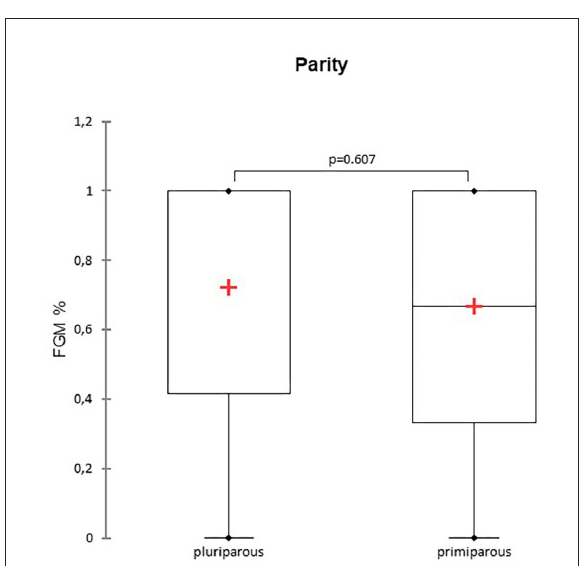
FIGURE3 The box plot reports the percentage of fetuses showing fetal gastrointestinal motility (FGM%) in pluriparous and primiparous bitches. The mean is indicated as a red cross ( + ).